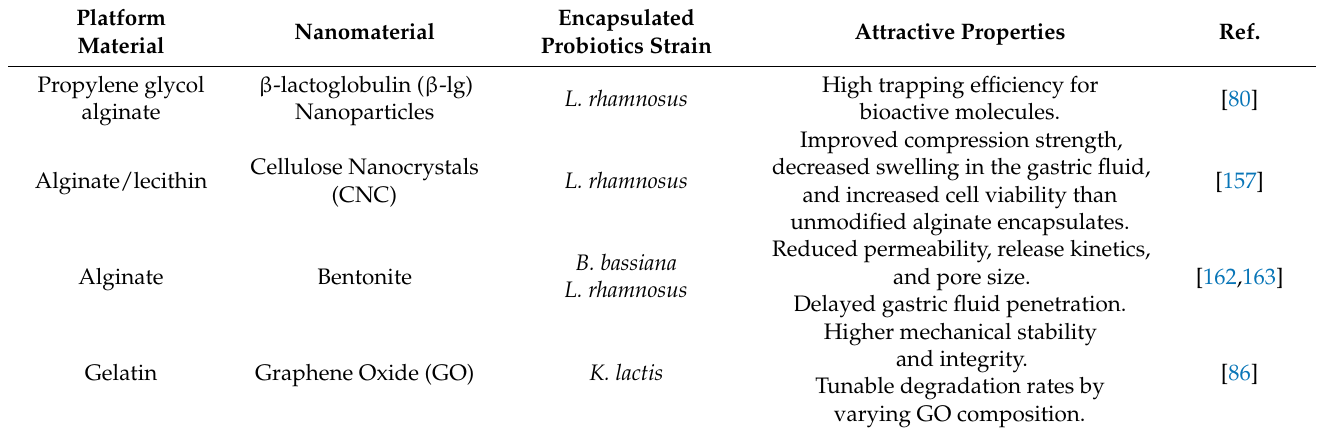
Table 4. Recent studies in probiotic encapsulation employing nanostructured